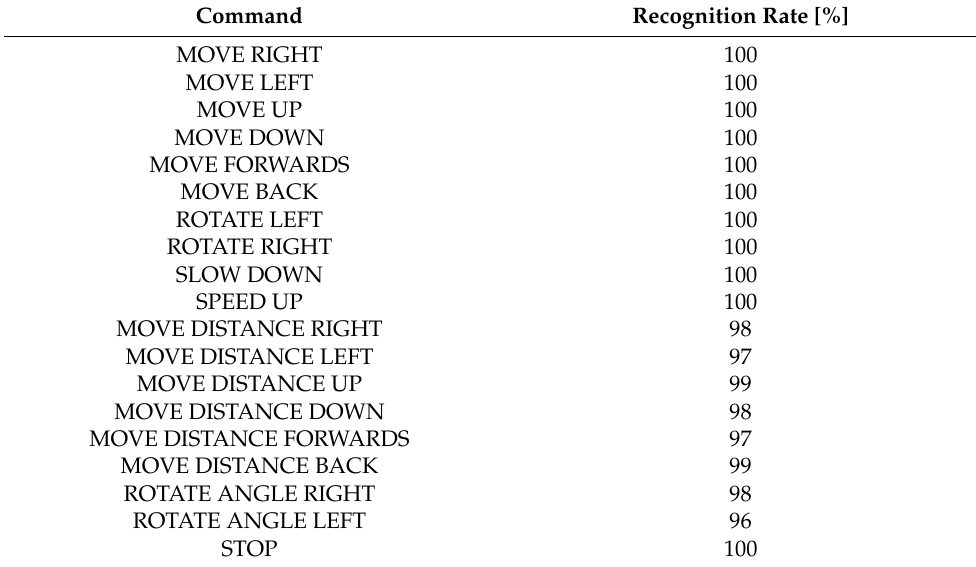
Table 3. Recognition rates for individual voice